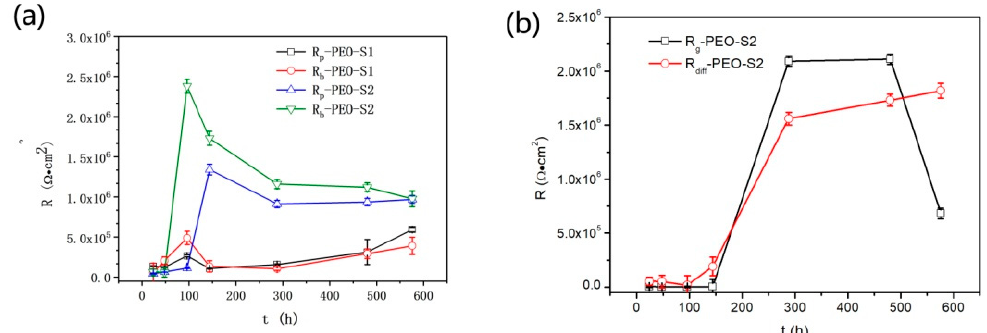
Figure 9. The fitted results of EIS data simulations for multiple PEO/Silane coated samples. ( a ) R p and R b ( b ). R g and R diff .